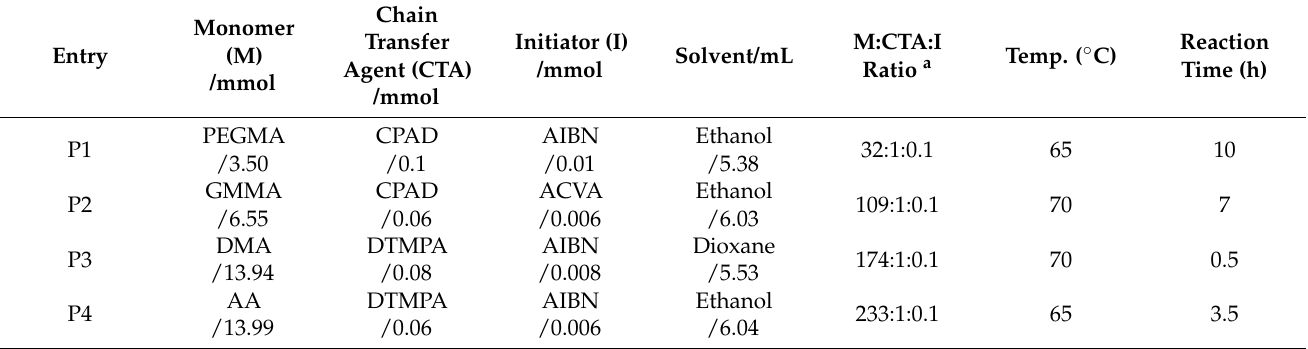
Table 1. Summary of reaction conditions for the synthesis of polymers P1 to P4.